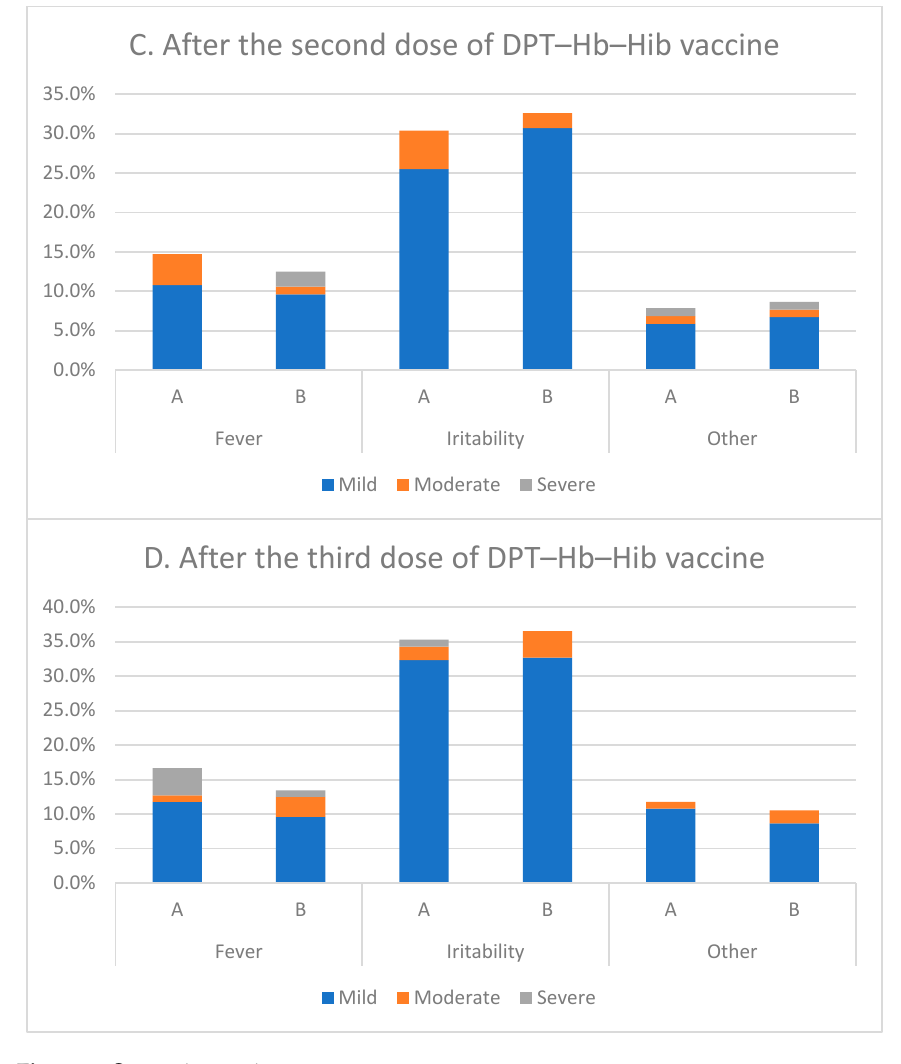
Figure 3. Systemic reaction.